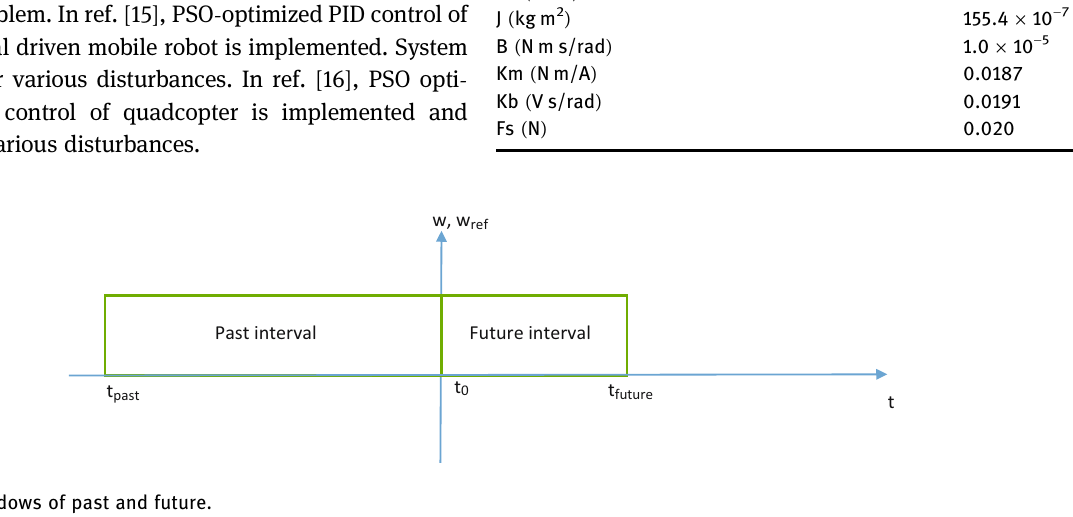
Figure 4: Windows of past and